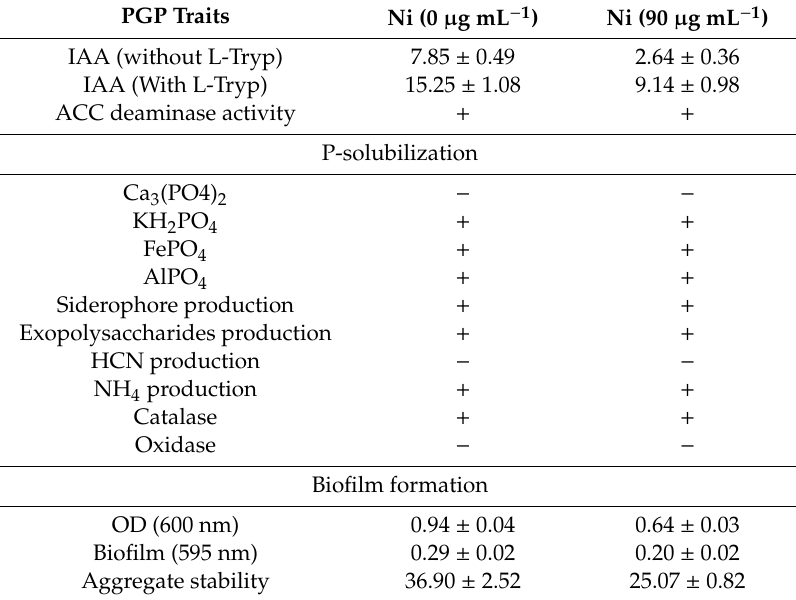
Table 1. In Vitro plant growth promoting (PGP) characteristics of Caulobacter sp. MN13 under normal and Ni-stressed